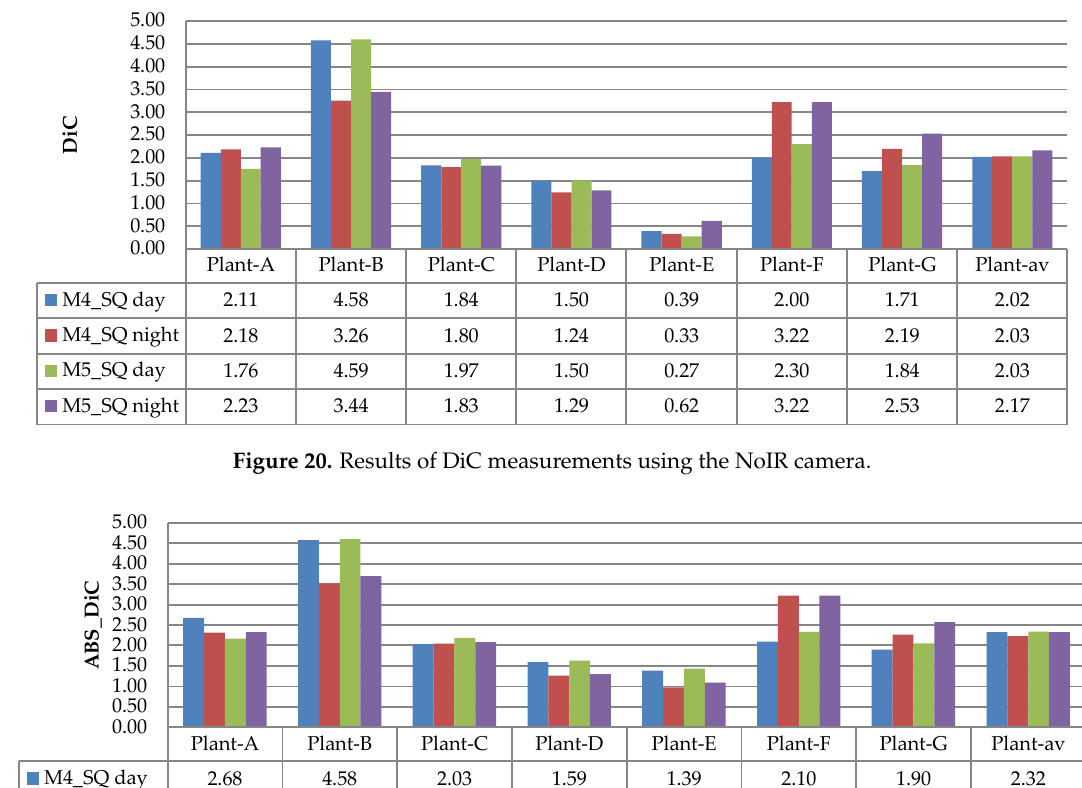
Figure 19. Leaf counting results using NoIR camera: ( a , d ) without miscounting errors; ( b , c , e , f ) with miscounting errors. The evaluation results of DiC and ABS_DiC are given in Figures 20 and 21, respec- tively. In the figures, the performances of leaf counting in the day and night images are compared using seven plants: Plant-A to Plant-G. The Plant-av represents the average value of the seven plants.